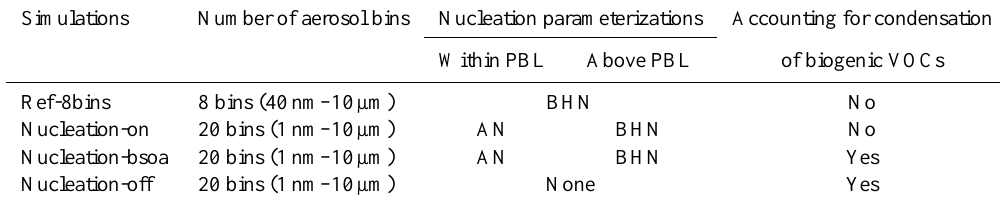
Table 2. Description of model simulations: AN is activation nucleation parameterization, and BHN is binary homogeneous nucleation parameterization, which is the default option in the WRF-Chem model (see Sects. 1 and